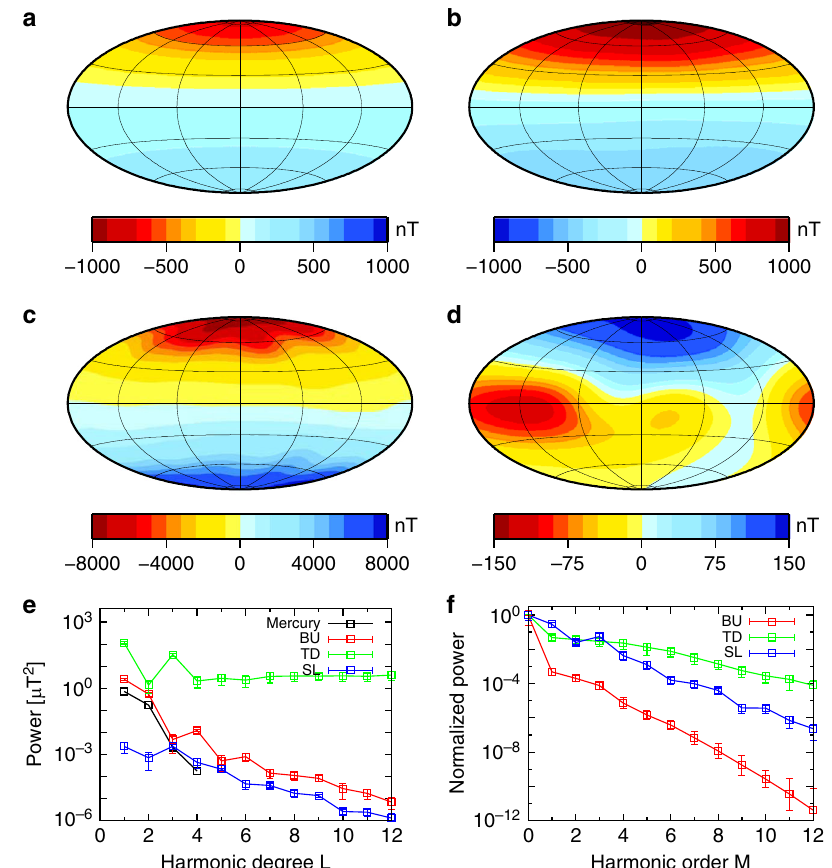
Fig. 2 Snapshots of the radial magnetic fi eld distribution and time-averaged power spectrum with standard deviation at Mercury ’ s surface. a MESSENGER observation 2 ; b BU1; c TD1; d SL1. The magnetic fi eld is scaled by 2 ρμη Ω ð Þ 1 = 2 = 0.14 mT, where ρ = 6980 kg m − 3 is density 29 , μ = 4 π × 10 − 7 H m − 1 is magnetic permeability in a vacuum, η ~ 1 m 2 s − 1 is magnetic diffusivity 43 , and Ω = 1.2 × 10 − 6 s − 1 is planetary rotation rate. The thickness of the mantle is assumed to be 590 km 7,8,11 . Color scale is reversed in b for the purpose of illustration. The magnetic equator corresponds to where the radial component